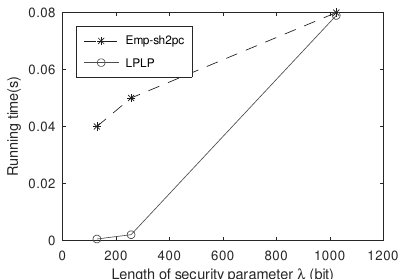
Figure 3. The running time comparison of additive operation between LPCP and